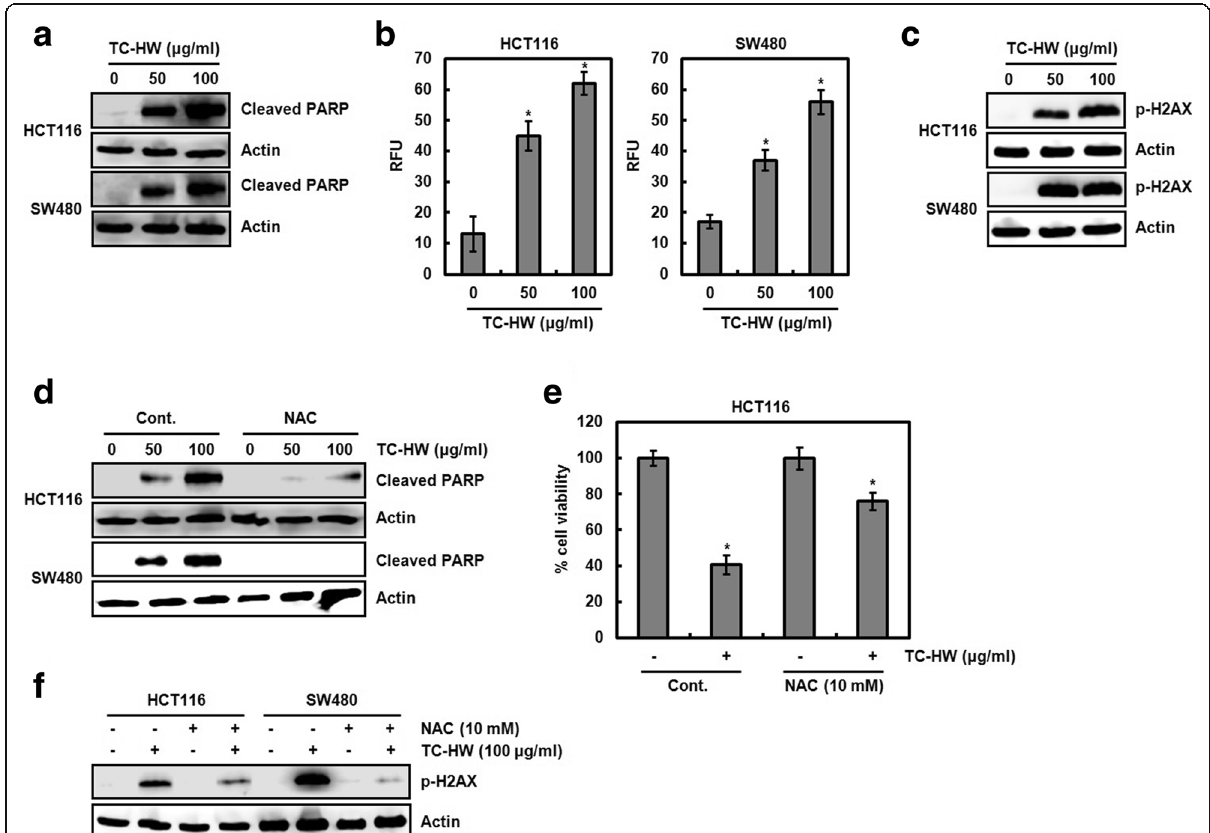
Fig. 4 Induction of apoptosis by TC-HW through ROS-dependent DNA damage. a HCT116 and SW480 were plated overnight and then treated with TC-HW at the indicated concentrations for 24 h. Cell lysates were subjected to SDS-PAGE and the Western blot was performed